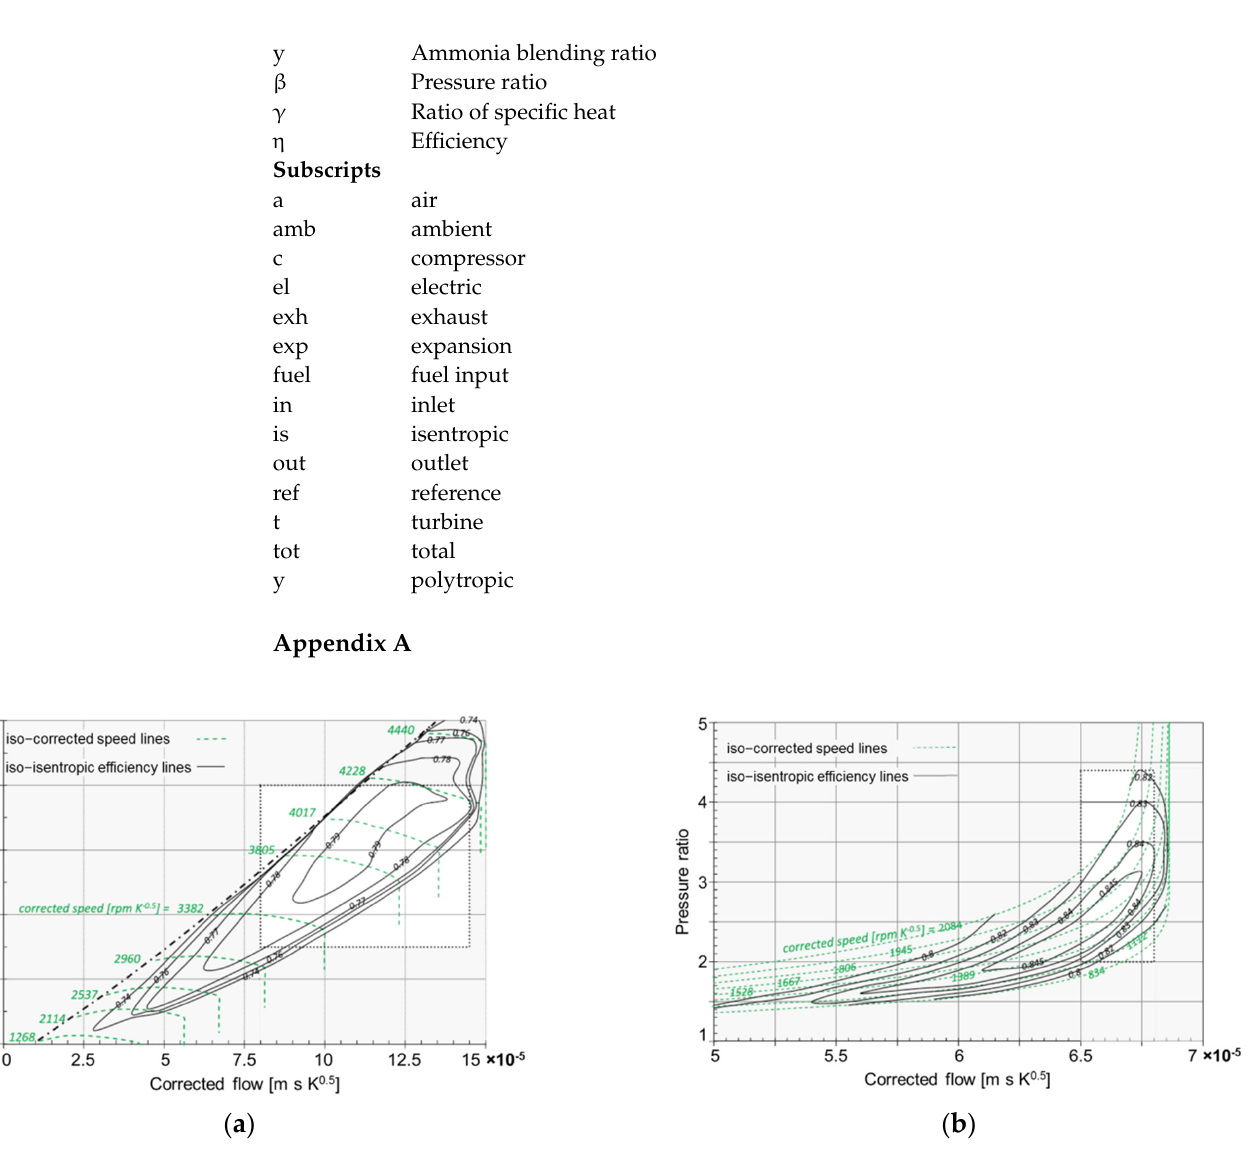
Figure A1. Performance maps of: ( a ) compressor; ( b ) turbine adapted from [33].